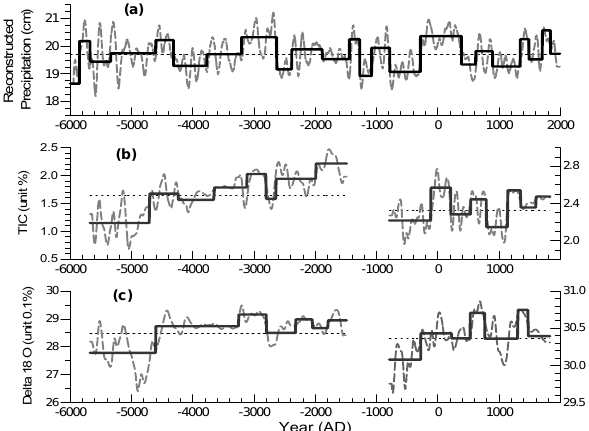
Fig. 7. The change points and episode averages (solid line), 101- year Gaussian filter (dashed line) and averages over the entire time series (dotted line) in the three series: (a) same as in Fig. 3b; (b) for the TIC and (c) for the δ 18 O series from sediment cores in Pyramid